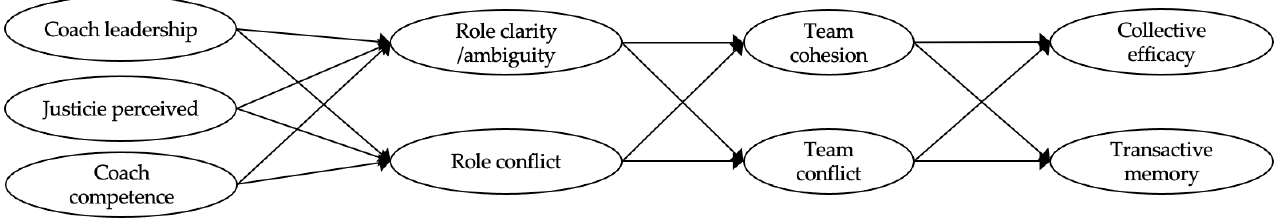
Figure 3. The hypothesized Model 2 of the relationships among variables.